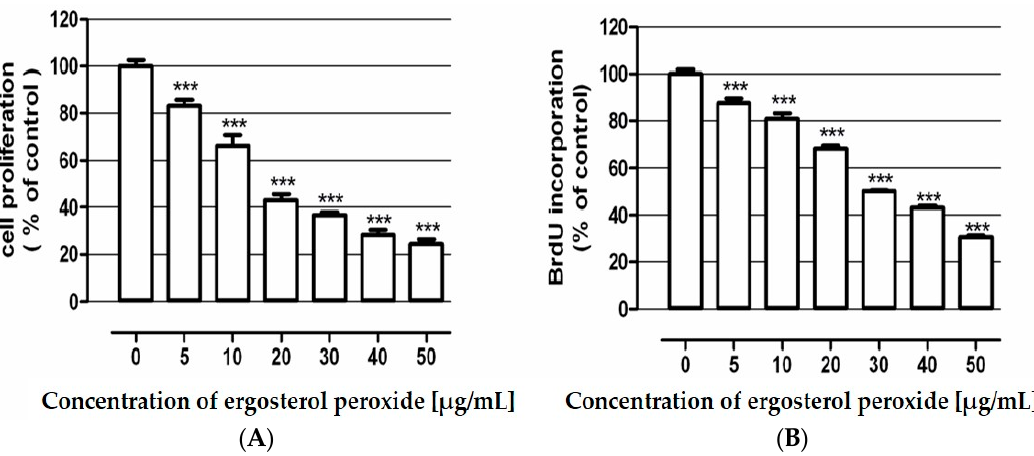
Figure 2. Antiproliferative effect of ergosterol peroxide in human colon adenocarcinoma cell line LS180. Cells were exposed to culture medium alone (control) and the medium supplemented with tested compound in concentrations ranging from 5–50 µg/mL for 96 h ( A ) and 48 h ( B ). Cell proliferation was quantified by MTT test ( A ) or BrdU assay ( B ). Results are presented as the mean ± SEM of 5–6 measurements. *** p < 0.001 vs. control, one-way ANOVA test; post test: Tukey.